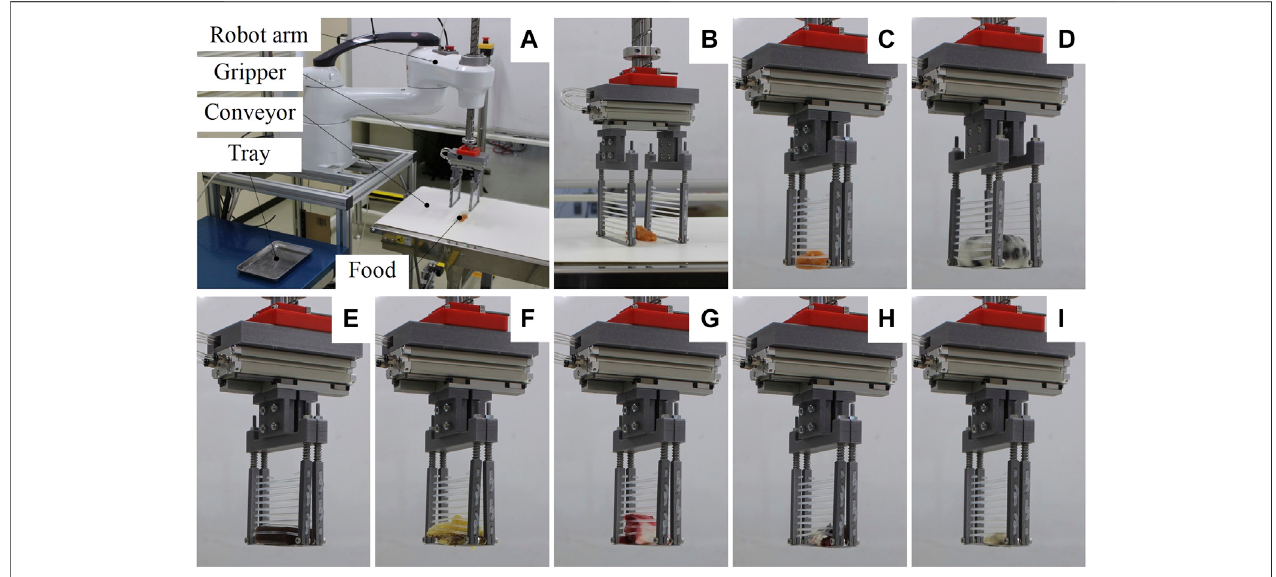
FIGURE 10 | (A) Experimental setup of the handling test (B) Opening state before grasping. Experimental snapshots while grasping and lifting the Pollock roe (C) , daifuku (D) , sweet bean jelly (E) , sweet potato tempura (F) , octopus leg (G) , carangidae fi sh (H) , and raw oyster (I) , respectively.